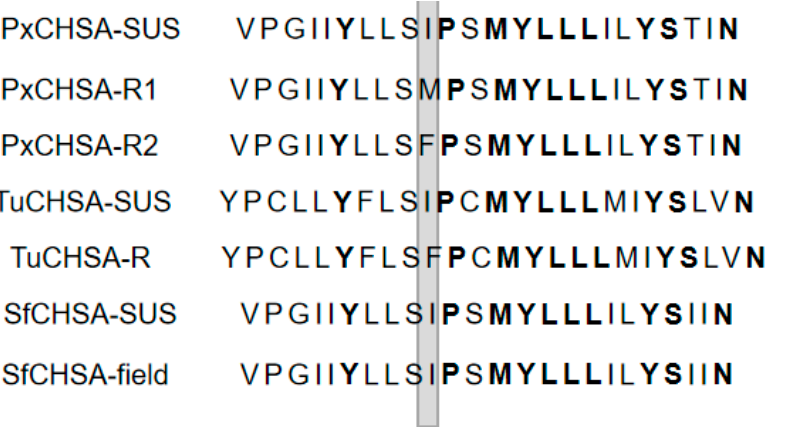
Figure 2. Aligned amino acid sequences of helix 5 in the C-terminal 5 transmembrane segments of CHSA. The positions of the I1017F substitution in etoxazole-resistant Tetranychus urticae [41] and I1042M/F in BPU insecticide-resistant P. xylostella [26] are indicated in gray. Conserved amino acid residues are shown in bold letters. PxCHSA-SUS, P. xylostella CHSA of the susceptible strain BCS-S (DDBJ/EMBL/GenBank accession number API61825); PxCHSA-R1, P. xylostella CHSA of the resistant strain [26]; PxCHSA-R2, P. xylostella CHSA of the resistant strain (China) [33]; TuCHSA-SUS, T. urticae CHSA of the etoxazole susceptible strain GSS (AFG28413); TuCHSA-R, T. urticae CHSA of the etoxazole-resistant strain EtoxR (AFG28419); SfCHSA-SUS, S. frugiperda CHSA of the susceptible strain; SfCHSA-field, S. frugiperda CHSA of field strains.